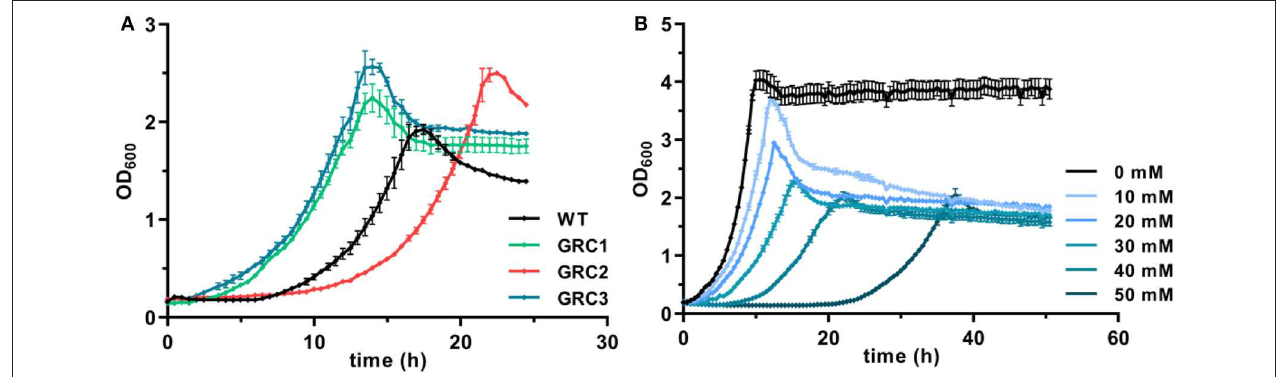
FIGURE 1 | Enhanced growth of genome-reduced Pseudomonas taiwanensis chassis strains in the presence of t -cinnamate. (A) Growth of the P. taiwanensis VLB120 wildtype and the three genome-reduced chassis strains in the presence of 30mM of t -cinnamate in mineral salts medium (MSM) containing 20mM of glucose. (B) Growth of P. taiwanensis GRC3 at increasing t -cinnamate concentrations (0–50mM) in MSM. Growth was monitored in the Growth Profiler ® , error bars represent the standard error of the mean ( n =